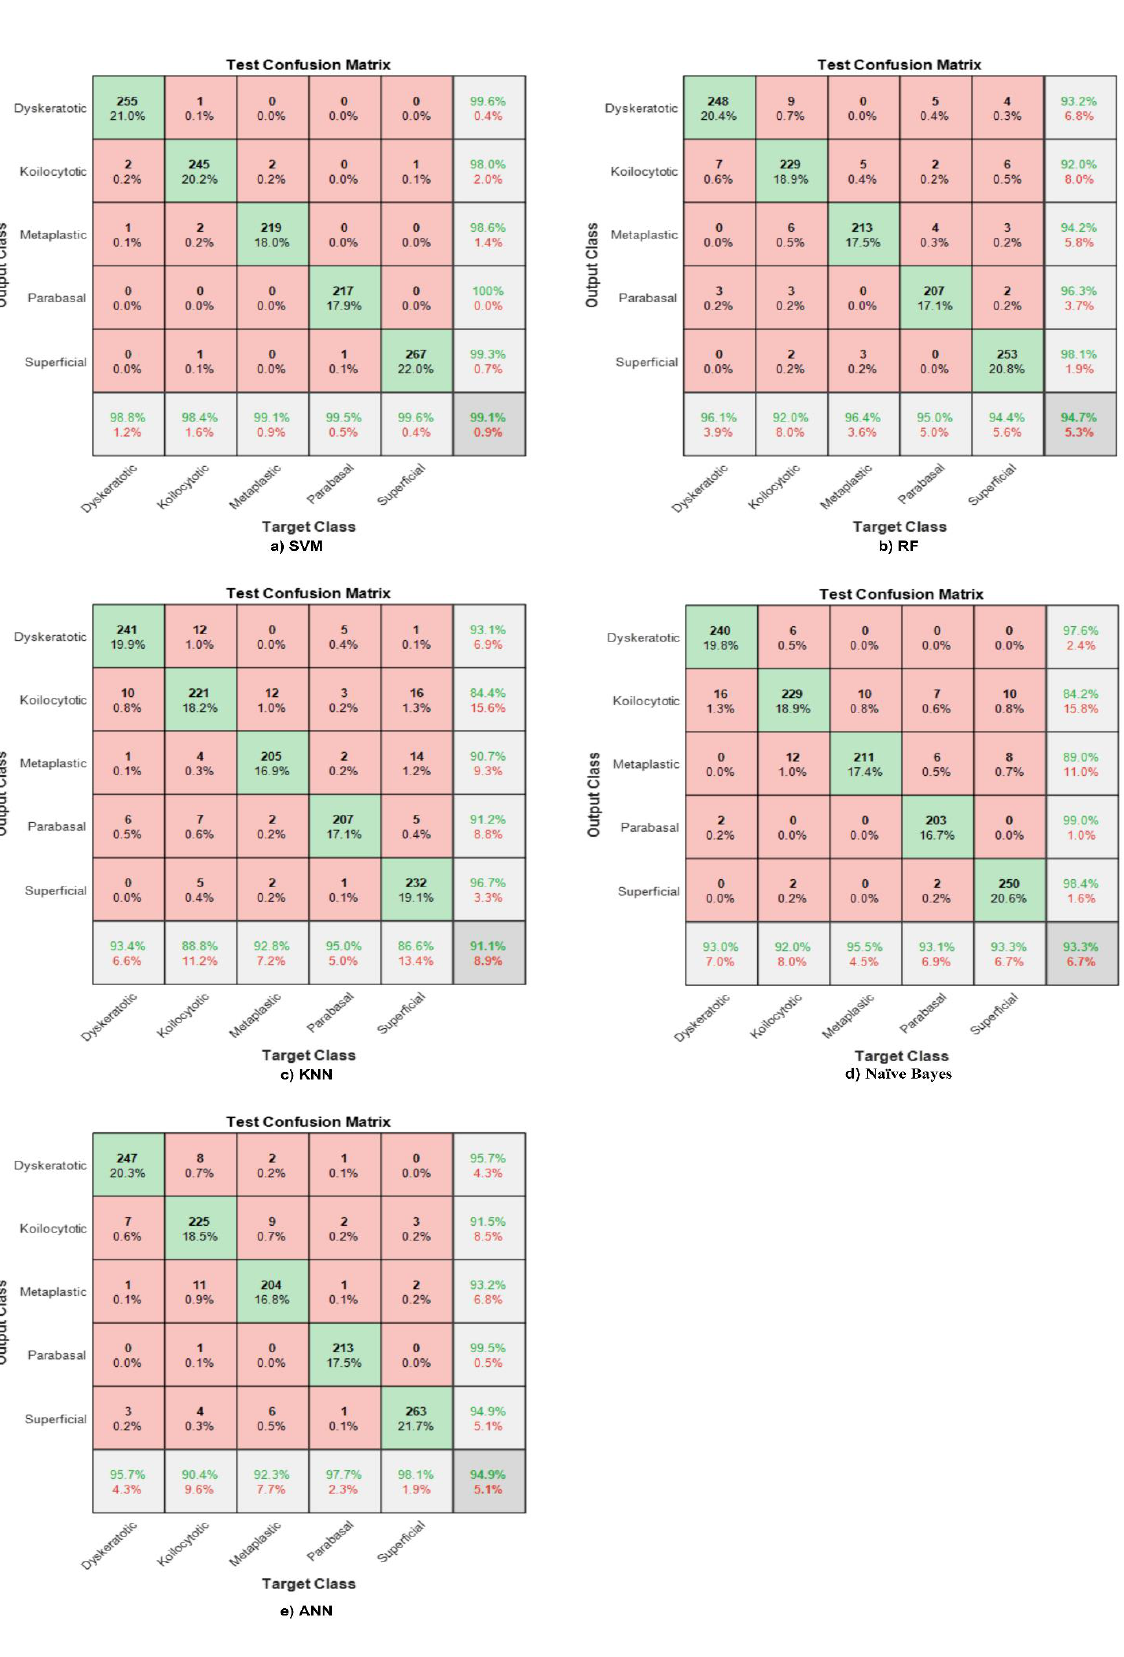
Figure 8. Confusion matrix with respect to CCA features for different ML classifiers. ( a ) SVM, ( b ) RF, ( c ) KNN, ( d ) Naïve Bays, ( e )